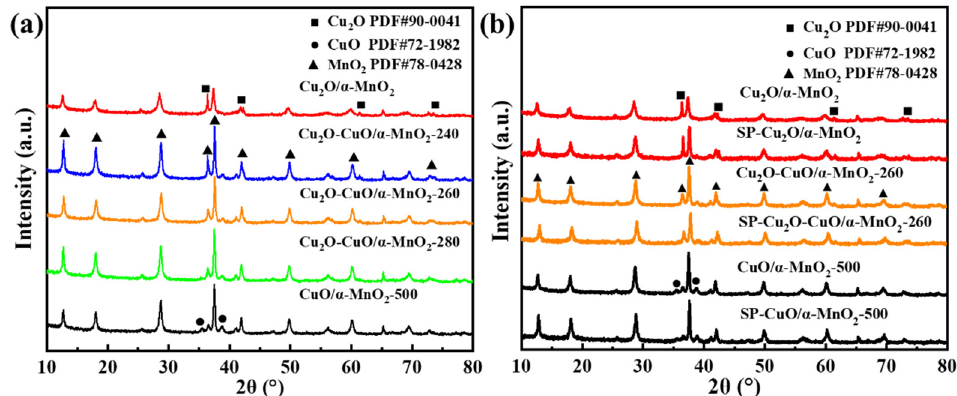
Figure 5. X-ray diffraction patterns of the as-prepared ( a ) Cu 2 O/ α -MnO 2 , Cu 2 O-CuO/ α -MnO 2 -T, and CuO/ α -MnO 2 -500 catalysts and ( b ) the XRD patterns of each catalyst after long-term stability tests (SP-).